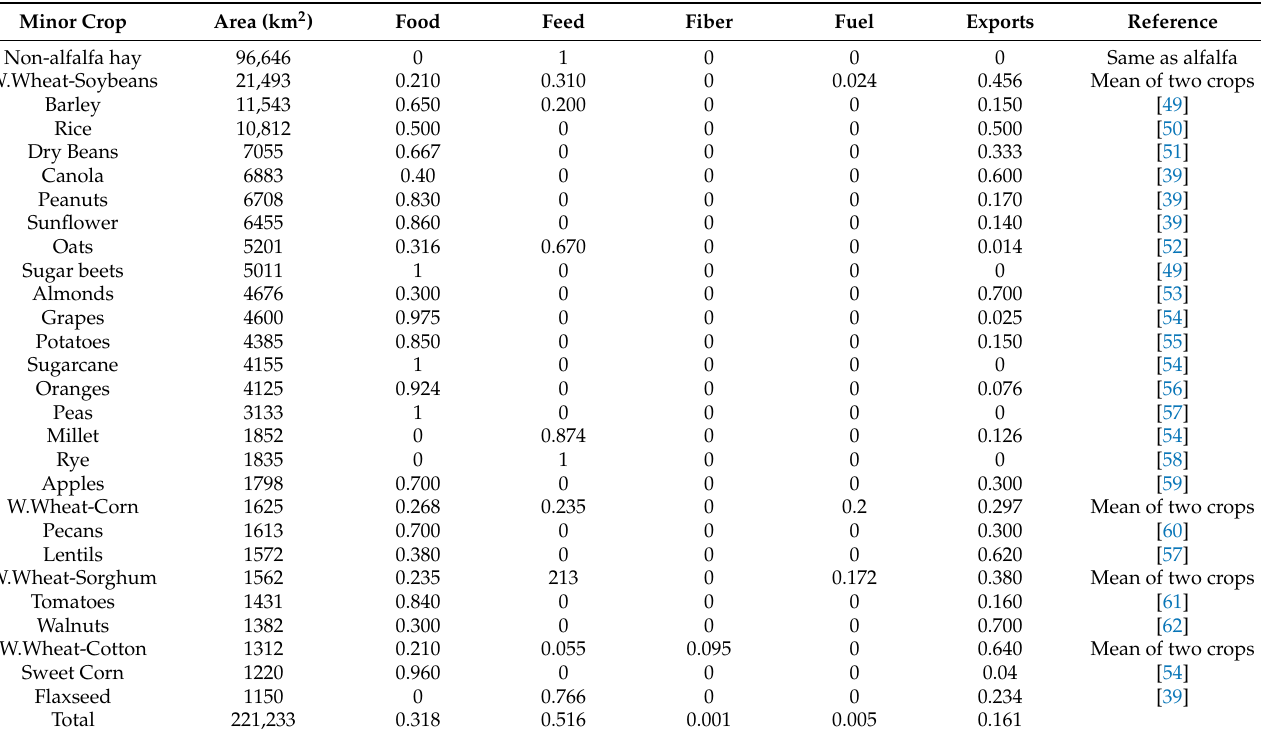
Table A2. Proportion of HANPP from minor crops allocated to food, livestock feed, biofiber, biofuel and exports in 2012. Together with major crops, these sum to 99% of U.S. cropland area in